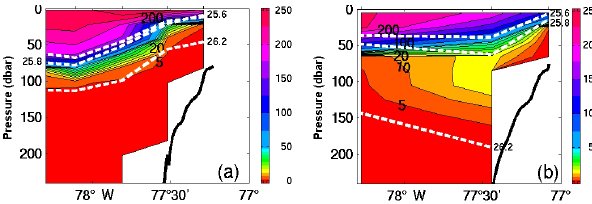
Figure 10. Oxygen section (color; inµmolkg − 1 ; same color scale in both frames) at ∼ 12 ◦ S off the Peruvian shelf for December 2012 (a) and October 2015 (b) . Three selected isopycnals are included as white dashed lines.